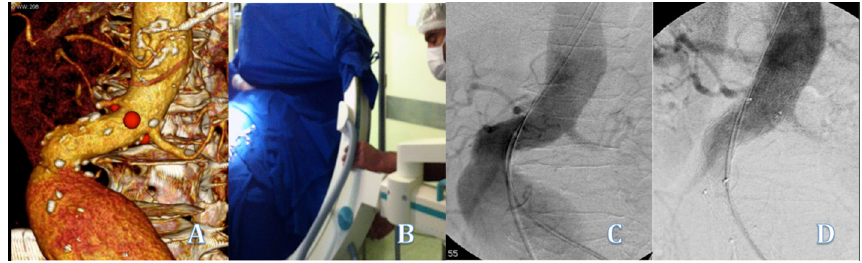
Fig. 4 - A - Tomographic image by 3D reconstruction. B - Intraoperative position of fluoroscopy unit, respecting the angles identified. C - Intraoperative arteriography. D - Final positioning of the